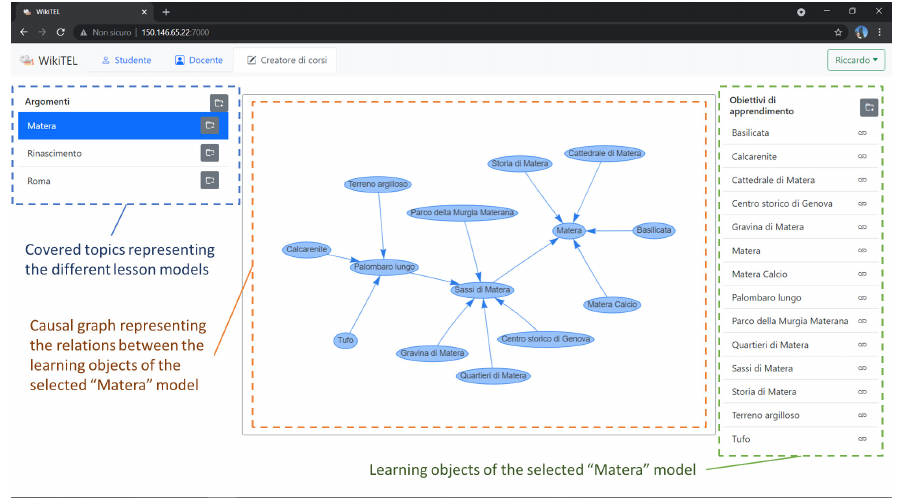
Figure 2. Supporting the design of the lessons’